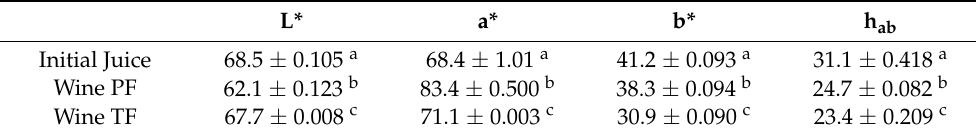
Table 3. CIELAB coordinates of initial juice and wines from Windsor